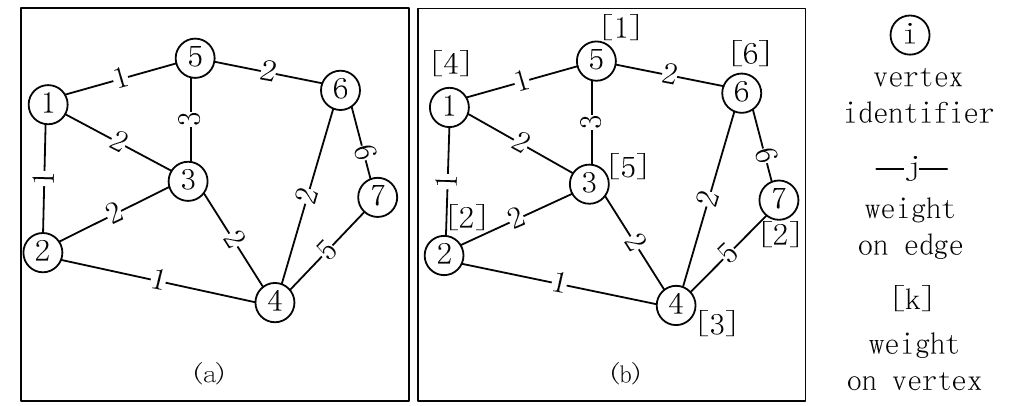
Figure 5. METIS graph. ( a ) Weighted graph with weights on edges; ( b ) Weighted graph with weights both on vertices and